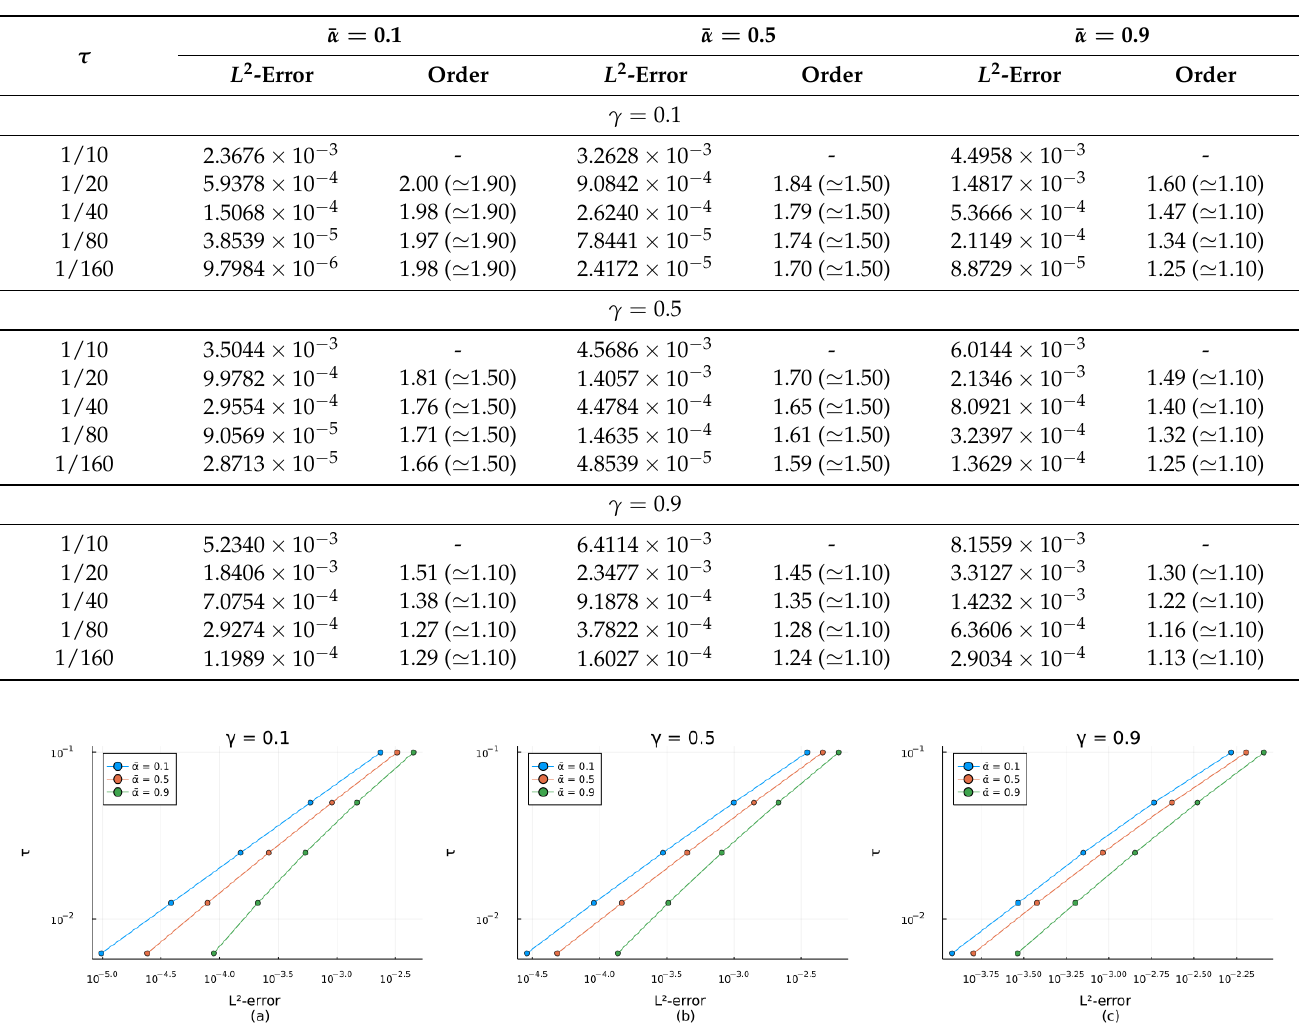
Table 3. L 2 -errors and convergence orders obtained for Example 2 when h = 1/40,000. The numbers in parentheses indicate the theoretical convergence order.